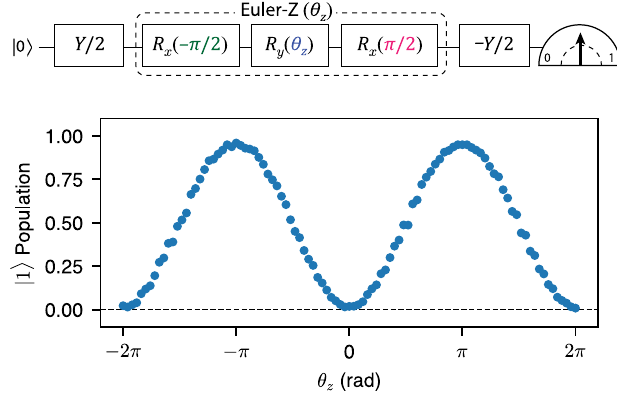
FIG. 34. Implementation of arbitrary Z gates by combining X and Y rotations. Experimental data of the Ramsey-type experi- ment to validate the Euler- Z gate. We vary the angle θ rotation, which effectively adjusts the rotation angle of the Euler- Z